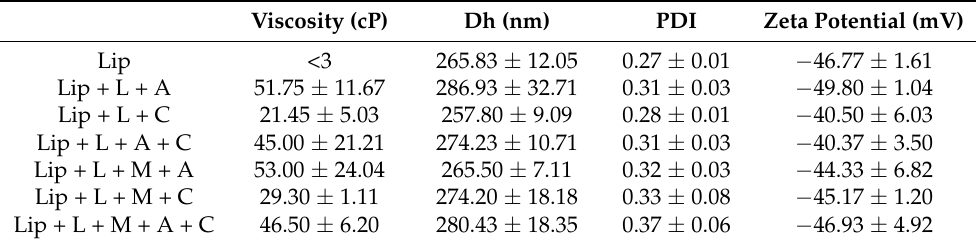
Table 1. Characteristic of liposomes without additives (Lip) and liposomes in mixtures containing different additives (L: lactose; M: mannitol; C: carboxymethylcellulose; A: alginate). Three replicates. Viscosity (cP) Dh (nm) PDI Zeta Potential (mV) Lip <3 265.83 ± 12.05 0.27 ± 0.01 − 46.77 ± 1.61 Lip + L + A 51.75 ± 11.67 286.93 ± 32.71 0.31 ± 0.03 − 49.80 ± 1.04 Lip + L + C 21.45 ± 5.03 257.80 ± 9.09 0.28 ± 0.01 − 40.50 ± 6.03 Lip + L + A + C 45.00 ± 21.21 274.23 ± 10.71 0.31 ± 0.03 − 40.37 ± 3.50 Lip + L + M + A 53.00 ± 24.04 265.50 ± 7.11 0.32 ± 0.03 − 44.33 ± 6.82 Lip + L + M + C 29.30 ± 1.11 274.20 ± 18.18 0.33 ± 0.08 − 45.17 ± 1.20 Lip + L + M + A + C 46.50 ± 6.20 280.43 ± 18.35 0.37 ± 0.06 − 46.93 ± 4.92 Concerning viscosity, samples with alginate showed higher values than carboxymethyl- cellulose, irrespective of containing L (51.75 ± 11.67 cP vs. 21.45 ± 5.03 cP) or L +